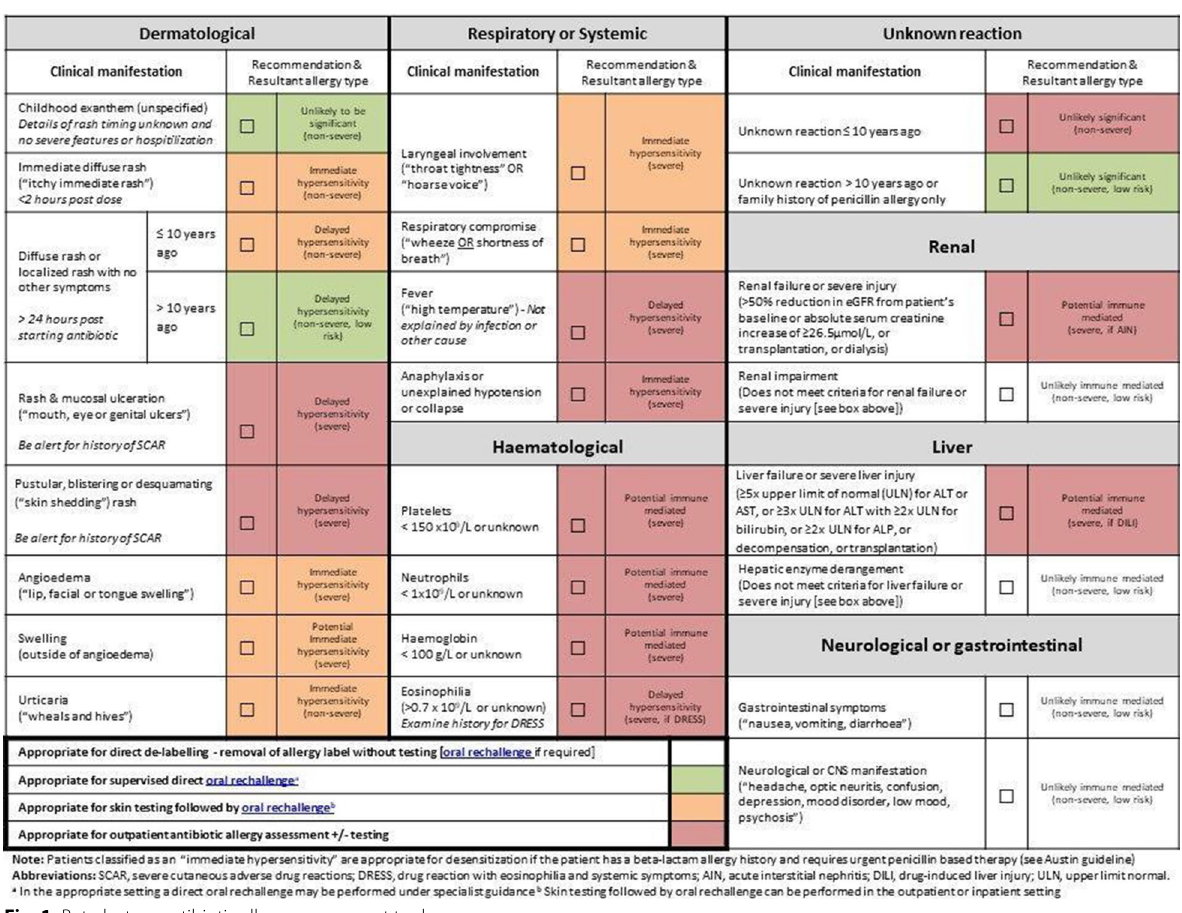
Fig. 1 Beta‑lactam antibiotic allergy assessment